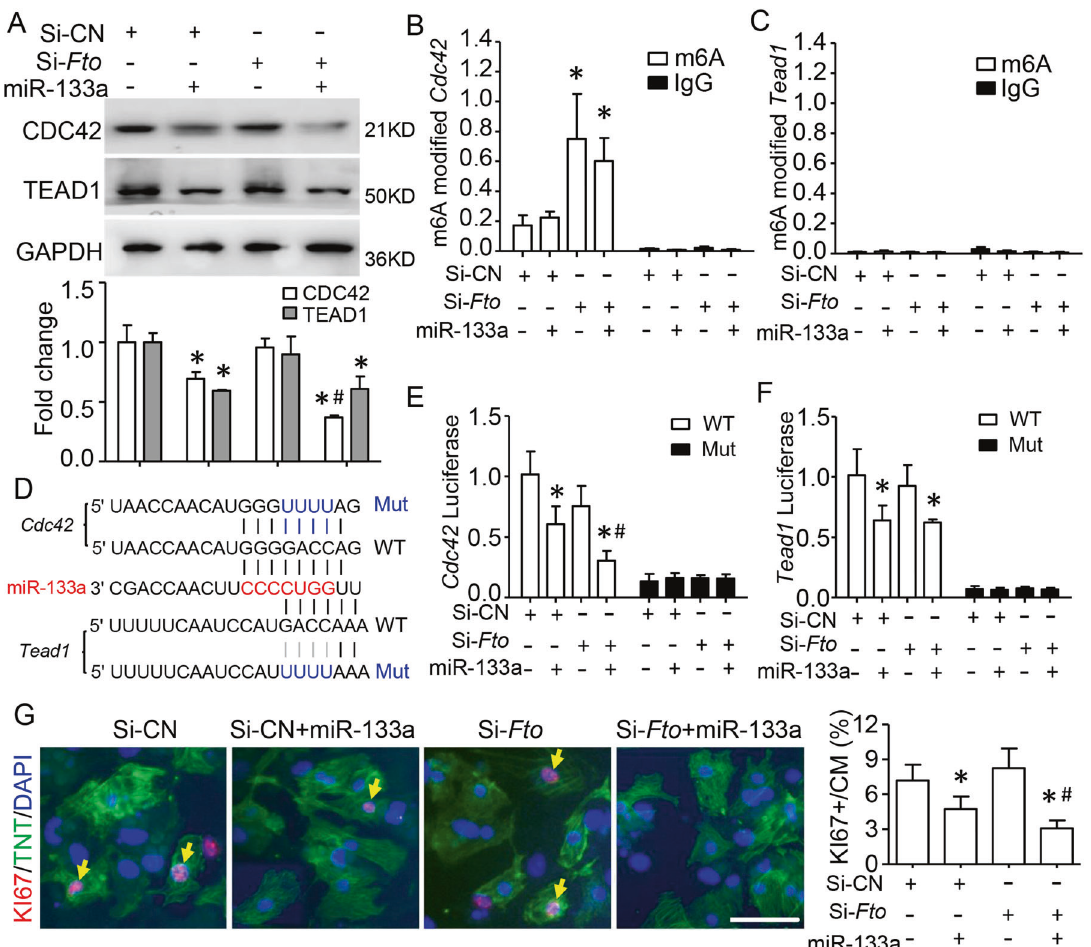
Fig. 3 m6A modi fi cation facilities miR-133a binding and preventing cardiac proliferation. Primary cultured mice neonate cardiomyocyte (CM) was transfected with miR-133a and/or si- Fto . A Quantitative western blot analysis showed that the fold changes of CDC42 and TEAD1 protein. GAPDH served as the loading and normalization control for the quanti fi cation. B , C m6A-RIP-qPCR analyses showing m6A modi fi cation occupancy at the Cdc42, but not Tead1 mRNA in CMs. The enrichment of m6A was compared with 5% input. D Schematic showing the binding sequences (red font) of miR-133a on Cdc42 and Tead1 3 ’ UTR region. The mutation (Mut) sites were generated as blue fonts. E , F Luciferase reporter analysis demonstrating Fto knockdown reduced the activities of Cdc42 , but not Tead1 by miR-133a transfection. G Co-immuno fl uorescence staining of TNT (green) and KI67 (red) con fi rming that the proliferated CMs was decreased by miR-133a, and continued decreased when combined with Fto -knockdown. Scale bar = 50 μ m. Data are mean ± SD ( n = 4 per group). * p < 0.05 via Si-CN, # p < 0.05 via Si-CN and miR-133a, was determined by one-way ANOVA followed by Tukey ’ s test in ( B , E , F , and G